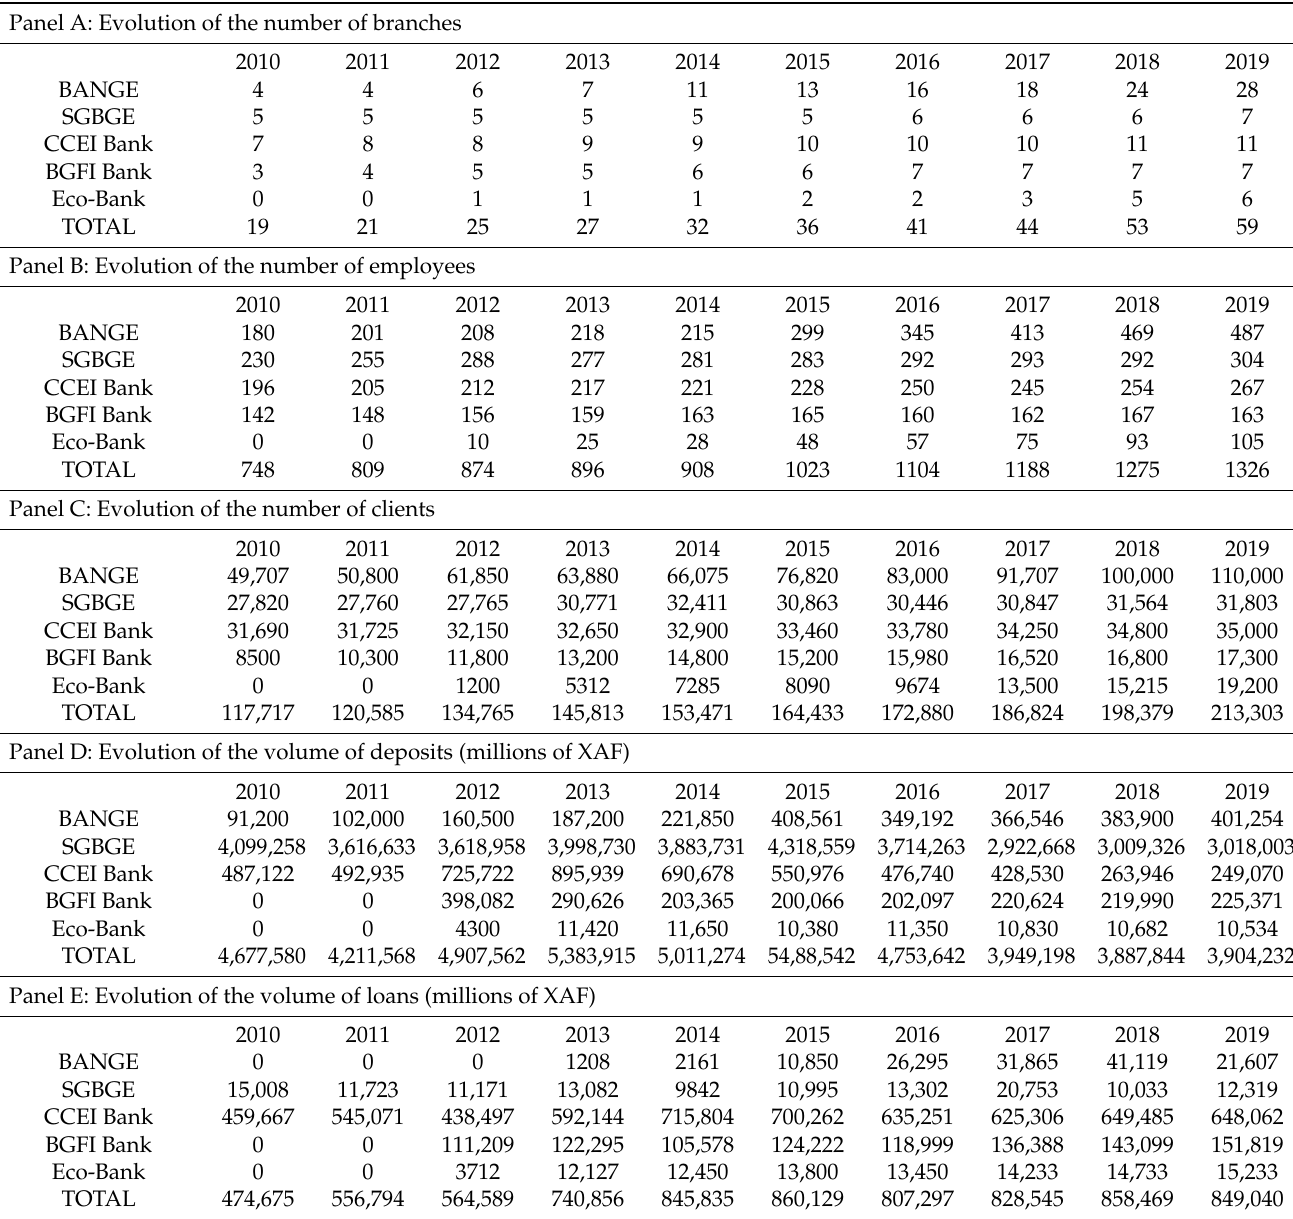
Table 1. Evolution of main variables of commercial banks